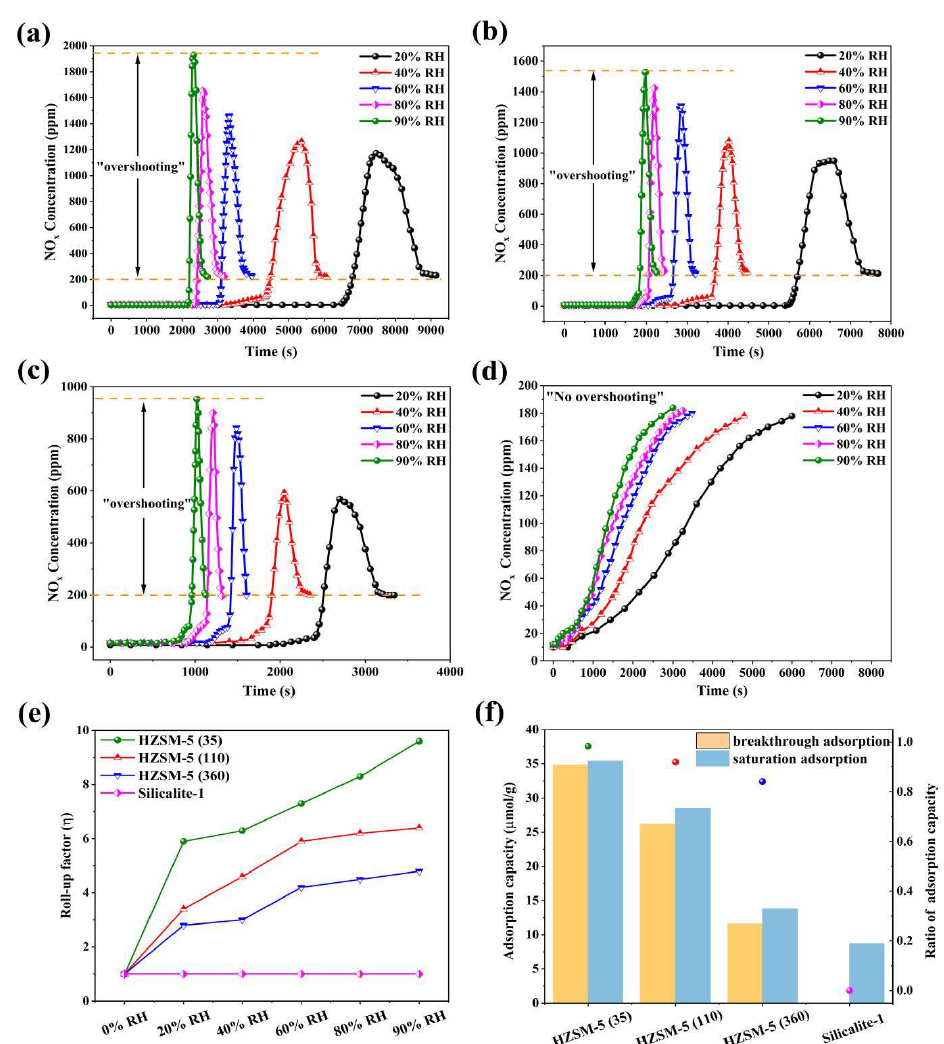
Figure 7. Breakthrough curves of NO x under different RH conditions ( a ) HZSM-5(35), ( b ) HZSM- 5(110), ( c ) HZSM-5(360), ( d ) Silicalite-1, ( e ) Roll-up factor and ( f ) Ratio of adsorption capacity.